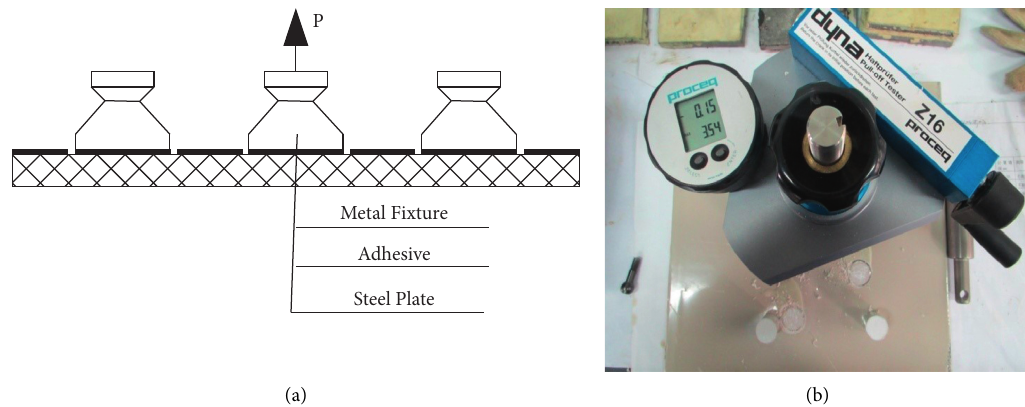
Figure 2: Pull-off adhesion strength test. (a) Schematic diagram of the test. (b) Photo of a portable adhesion tester.